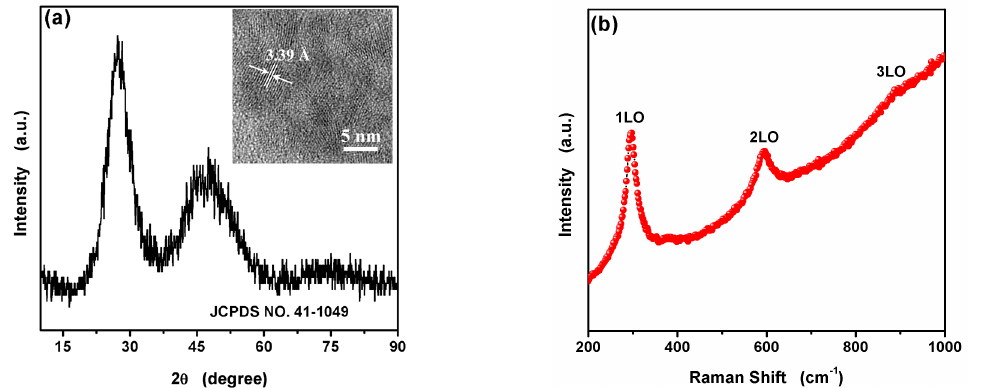
Figure 2. X-ray diffraction pattern ( a ) and Raman spectra ( b ) of as-synthesized L-Asp@CdS quantum dots (QDs). The inset of ( a ) shows the corresponding HRTEM image of L-Asp@CdS QDs.